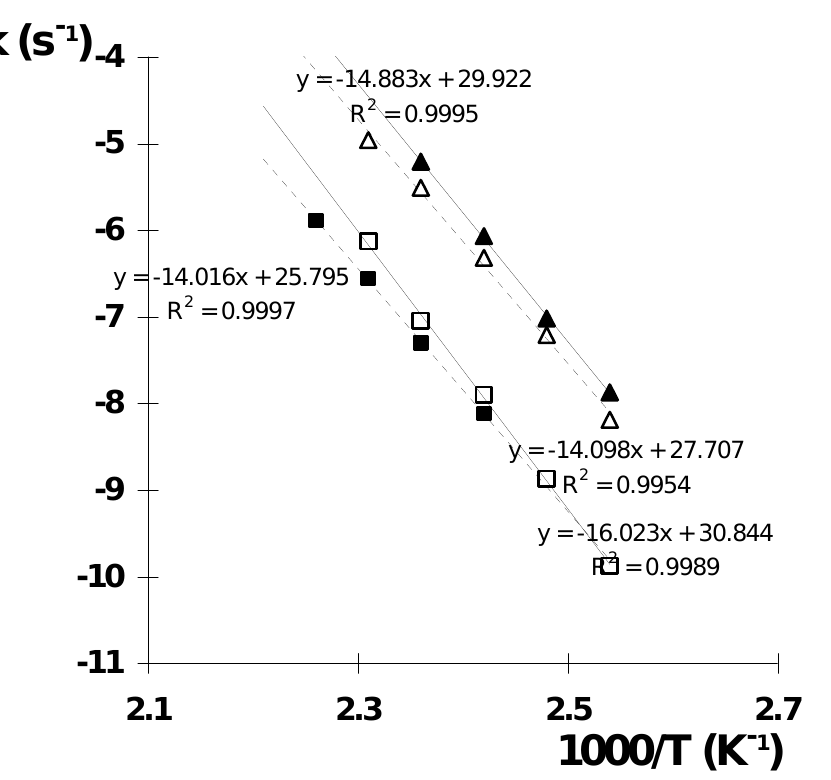
Figure 1 . Arrhenius Equation Plots for the Thermolysis of Trioxanes I (...) and II ( __ ) in